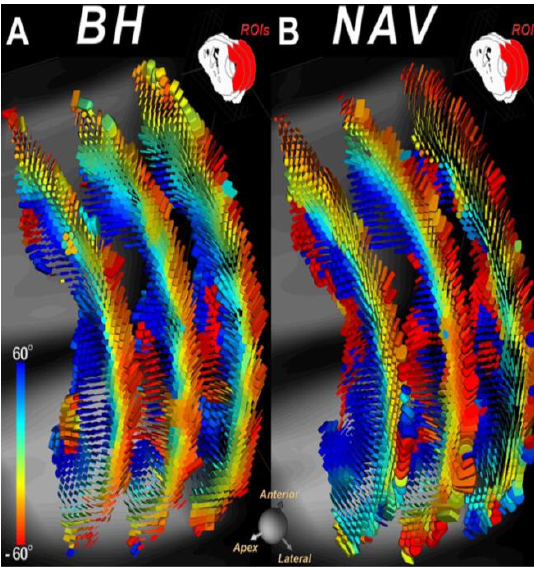
Figure 4. Experiments in open-chest pigs (n=32). The illustrations at the top show the uncoiled myocardial band according to Torrent Guasp. The points marked (p) show where the pairs of ultrasonic crystals have been implanted, following the direction of the fibers. The graph at the bottom shows mean (standard error) values for the times of onset of contraction at the points described above. The subpulmonary area and left ventricular free wall are the areas with the earliest contraction, followed by the mesocardium on the anterior aspect of the apex, which corresponds to the descending segment of the band. Finally, the epicardium contracts on the anterior aspect of the left ventricle corresponding to the ascending segment of the apical loop (own unpublished